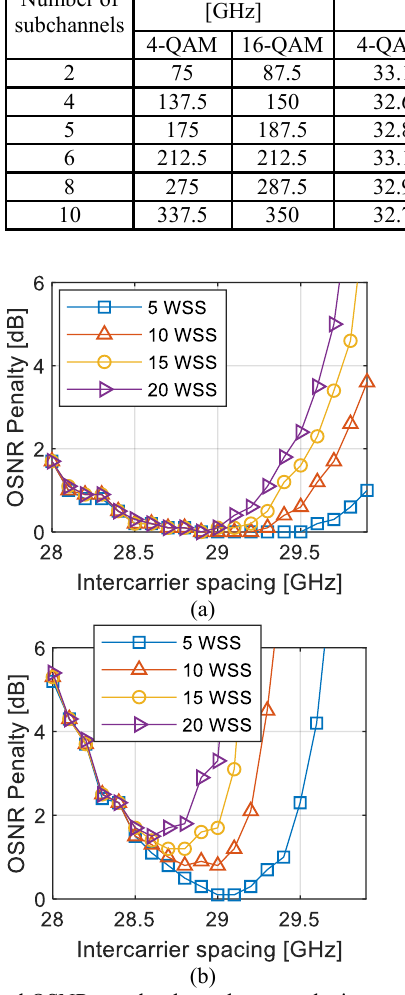
Fig. 1. Total OSNR penalty dependence on the intercarrier spacing after 5, 10, 15 and 20 WSSs, 10 subchannels, 28 GBd with 𝜌 =0.1 and a -6 dB WSS bandwidth of 300 GHz, for each WSS in the cascade, for (a) 4-QAM and (b) 16-QAM